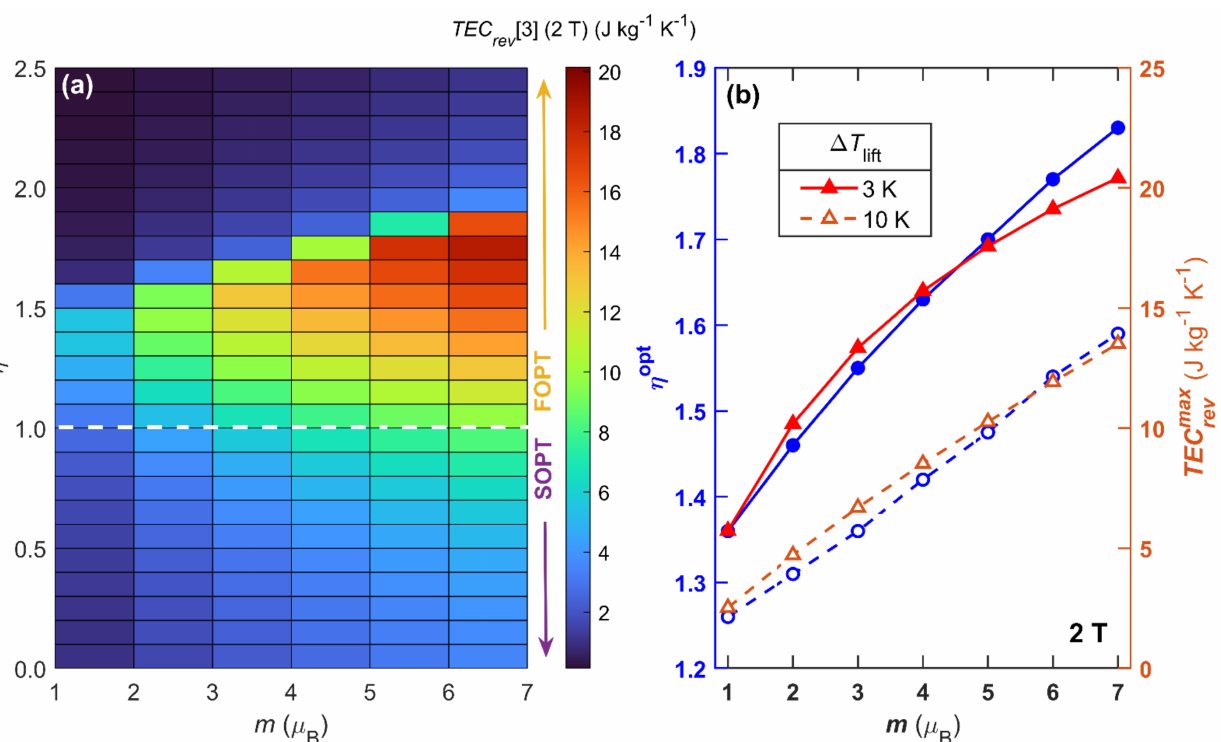
Figure 5. ( a ) TEC rev for 2 T using ∆ T lift of 3 K as a function of η and m ; ( b ) optimal η (left-y and circular symbols) and maximum TEC rev (right-y and triangular symbols) for 2 T using ∆ T lift of 3 K (solid symbols) and 10 K (hollow symbols) as a function of m